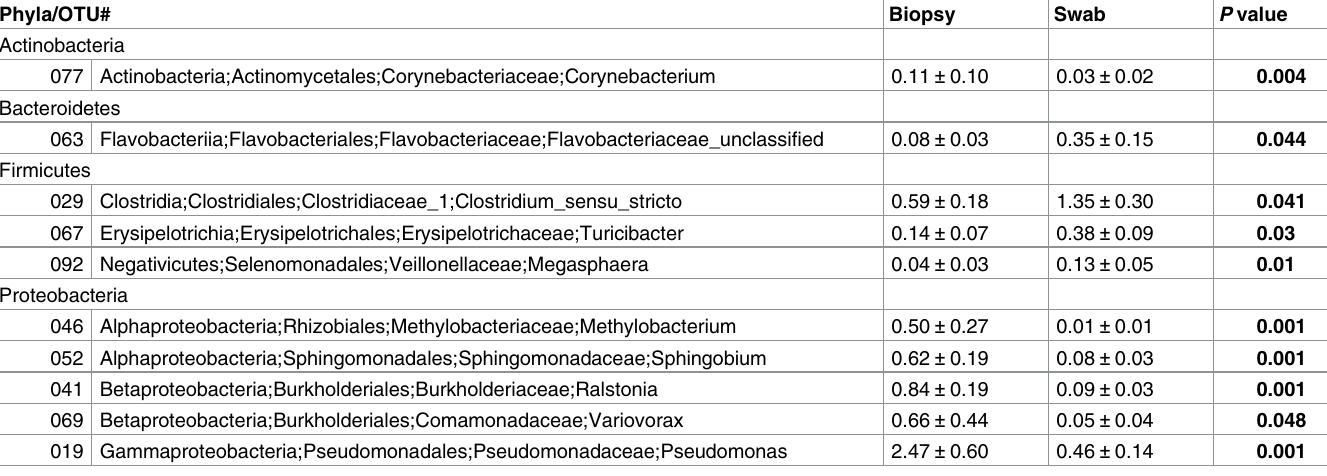
Table 2. OTUs identified by metastatsas significantly different between sampling methods.